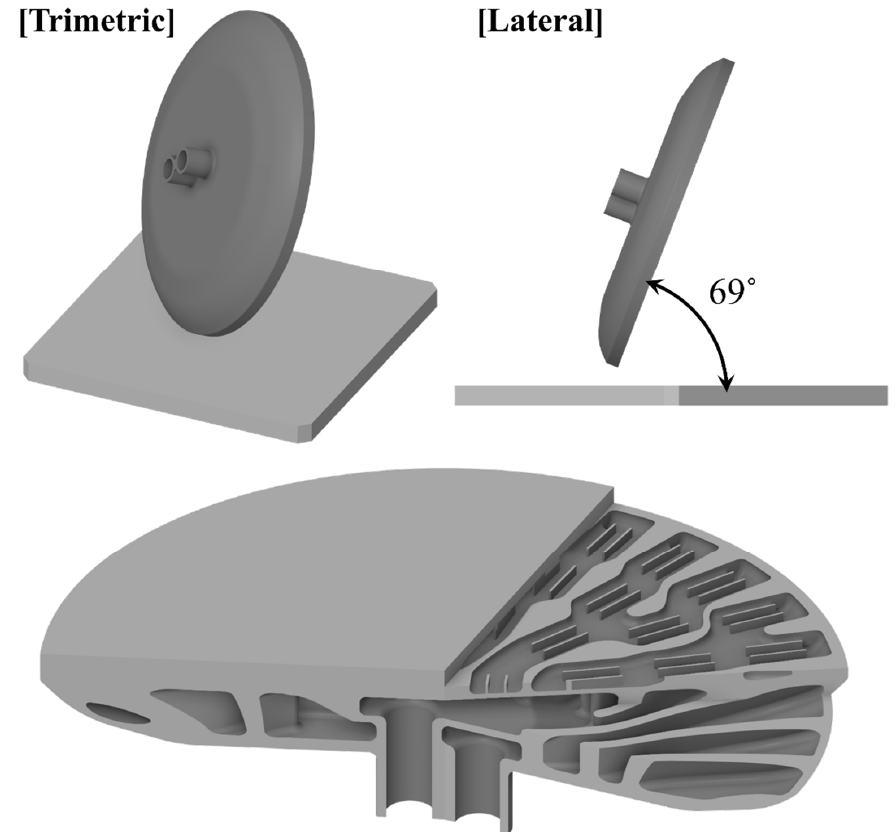
Figure 13. Build orientation and internal space of target heat exchanger model.